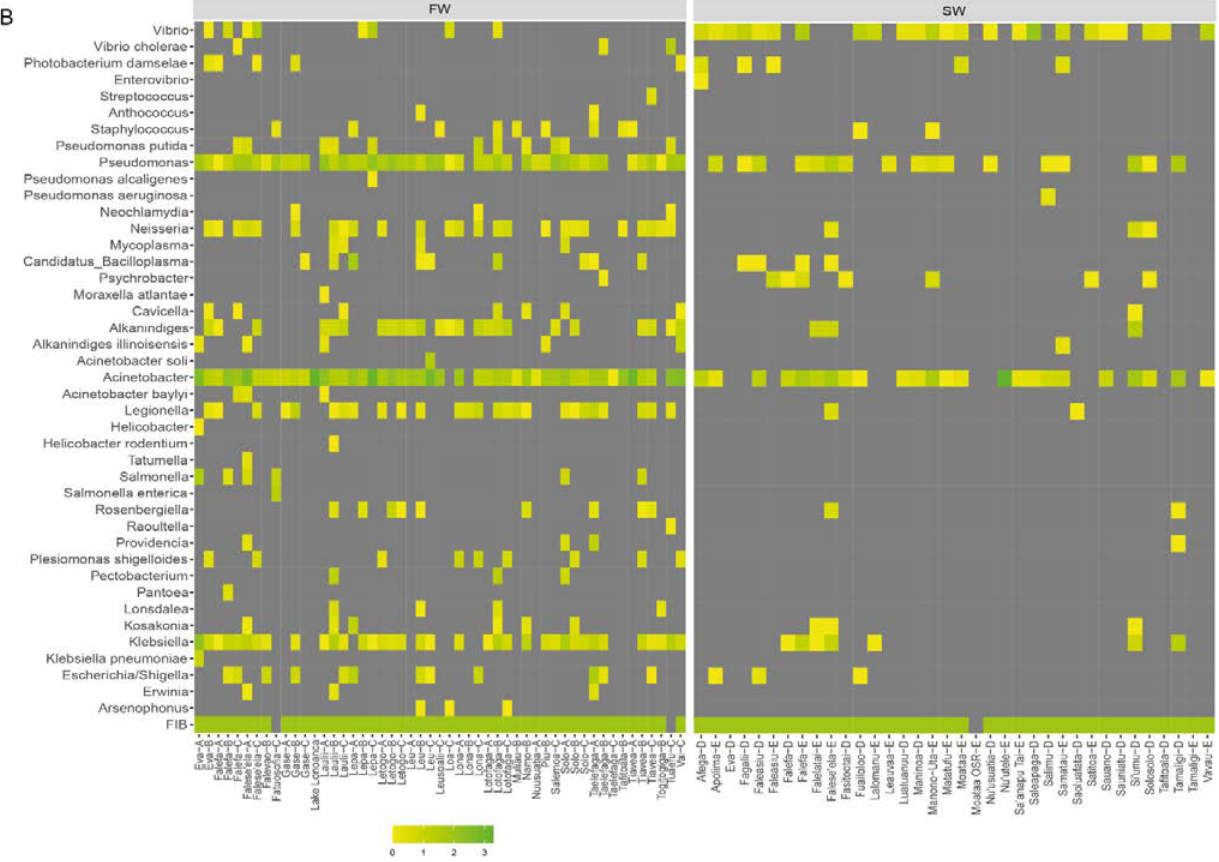
Figure 3. ( A ) Comparison of ASVs belonging to species and genera of potentially pathogenic bacteria at family level at the 5 sampling sites, Upstream-A ( n = 15), Midstream-B ( n = 18), Rivermouth-C ( n = 21), Inside-D ( n = 18) and Outside lagoon-E ( n = 16). Abundance of the individual bacterial is normalized for sites (circle size) and log10 total reads are color coded. ( B ) Heatmap showing the presence of FIB, log 10 read abundance (yellow = 1–10 reads, green = 1000+ reads) and prevalence of ASVs that belong to potentially pathogenic bacteria at the species and genus levels for individual sampling sites grouped into FW and SW.